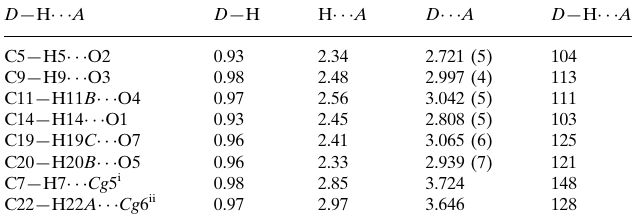
Hydrogen-bond geometry (A˚ , (cid:2)